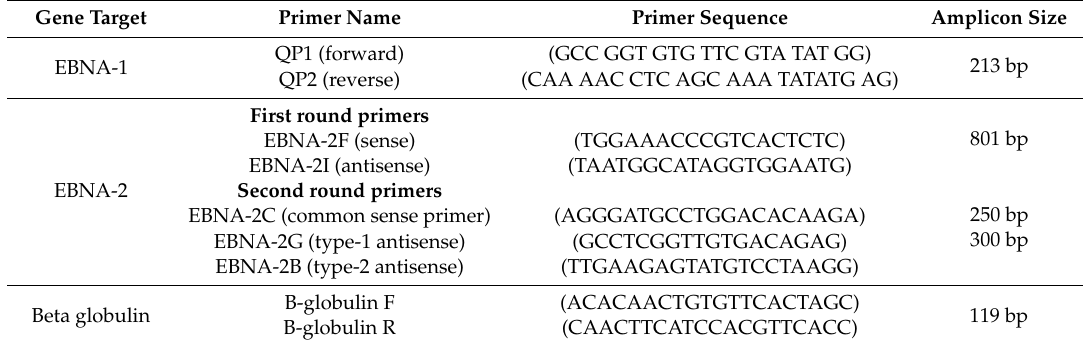
Table 1. Primers used for EBV detection, genotyping and beta globulin